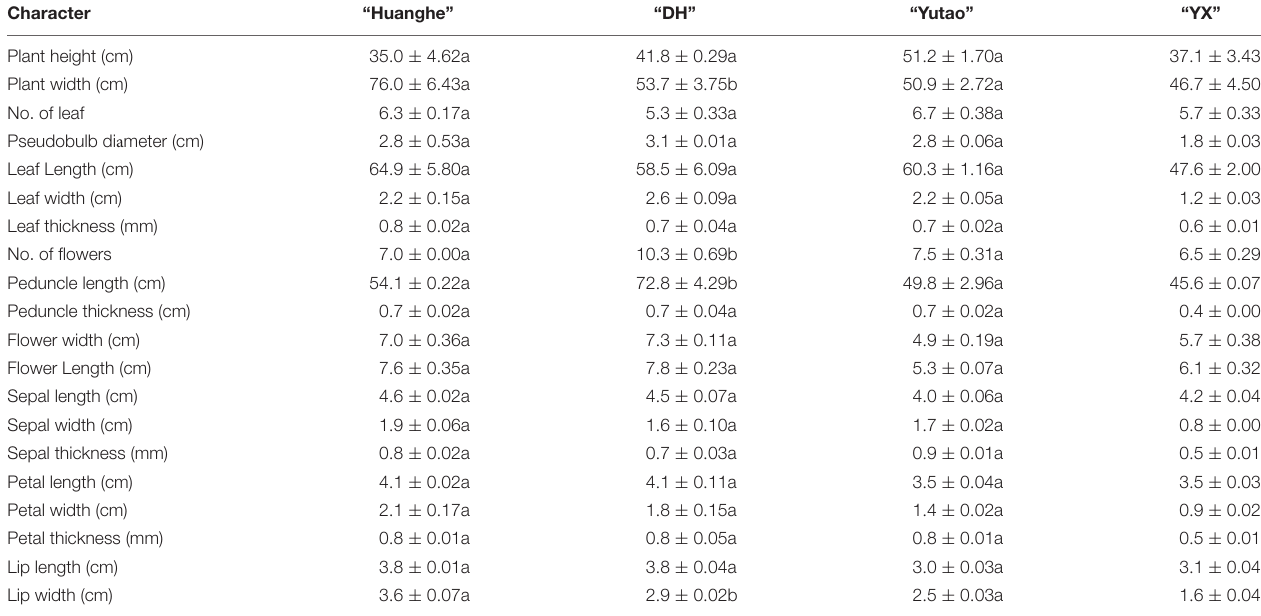
TABLE 3 | The effect of sexual polyploidization on morphological characteristics of Cymbidium cultivars. Character “Huanghe” “DH”